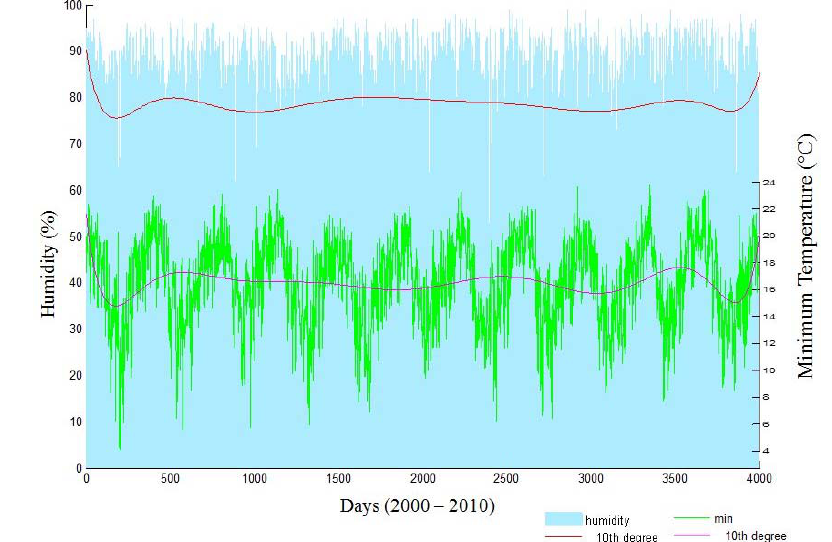
Figure 4. Daily minimum temperature and mean humidity and their decic polynomial during the period from 2000 to 2010 from the meteorological station INMET located at Mirante de Santana, São